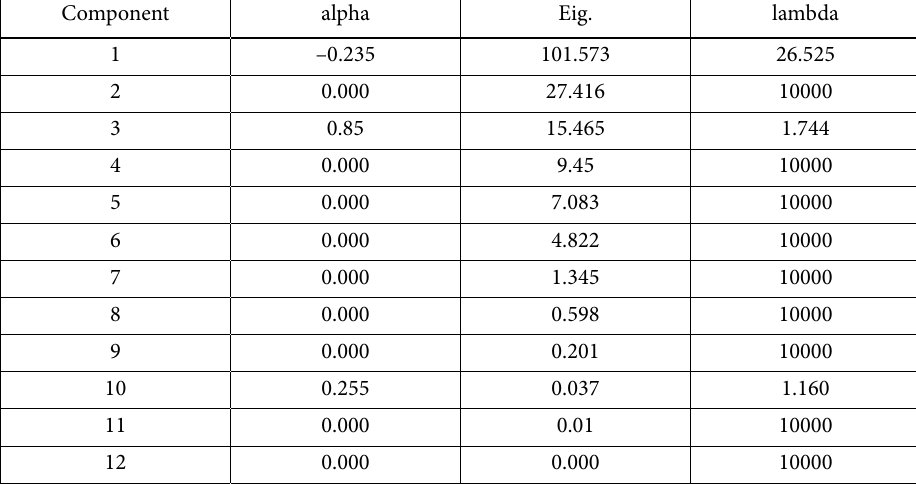
Table 2. Posterior Estimates of Principal Components of explanatory variables in case of Poland (source: own results)